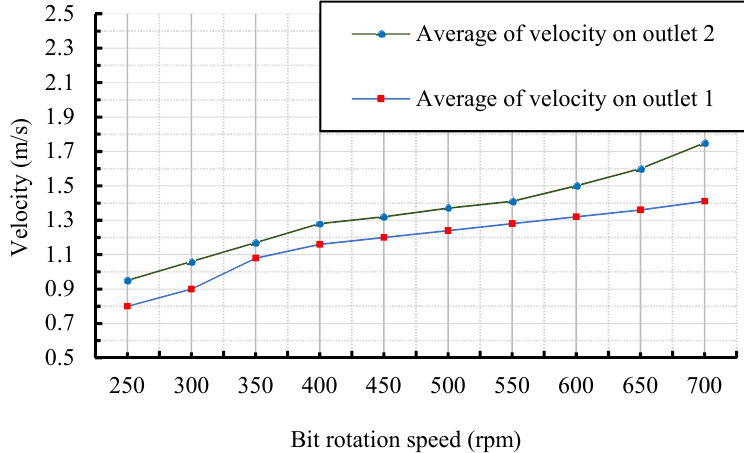
Figure 11. Effect of pump displacement on core surface velocity.